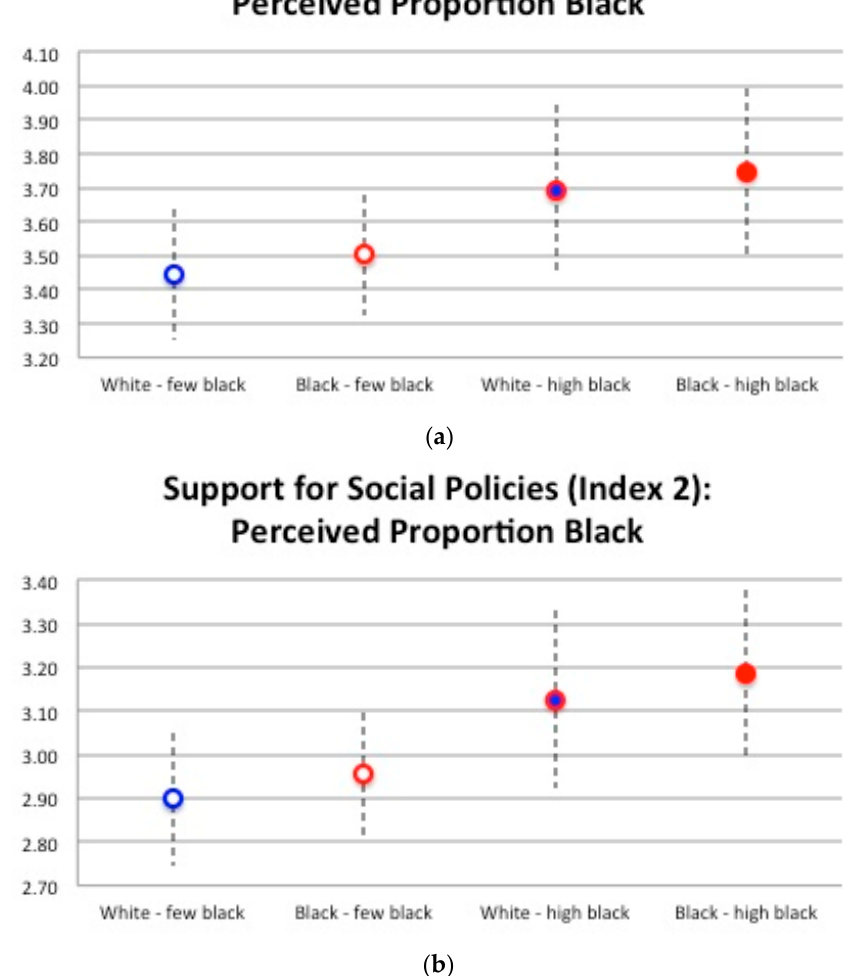
Figures 9. Predicted probabilities of support for redistribution ( a ) and social policies ( b ) by perceived proportion of whites for white and black respondents.